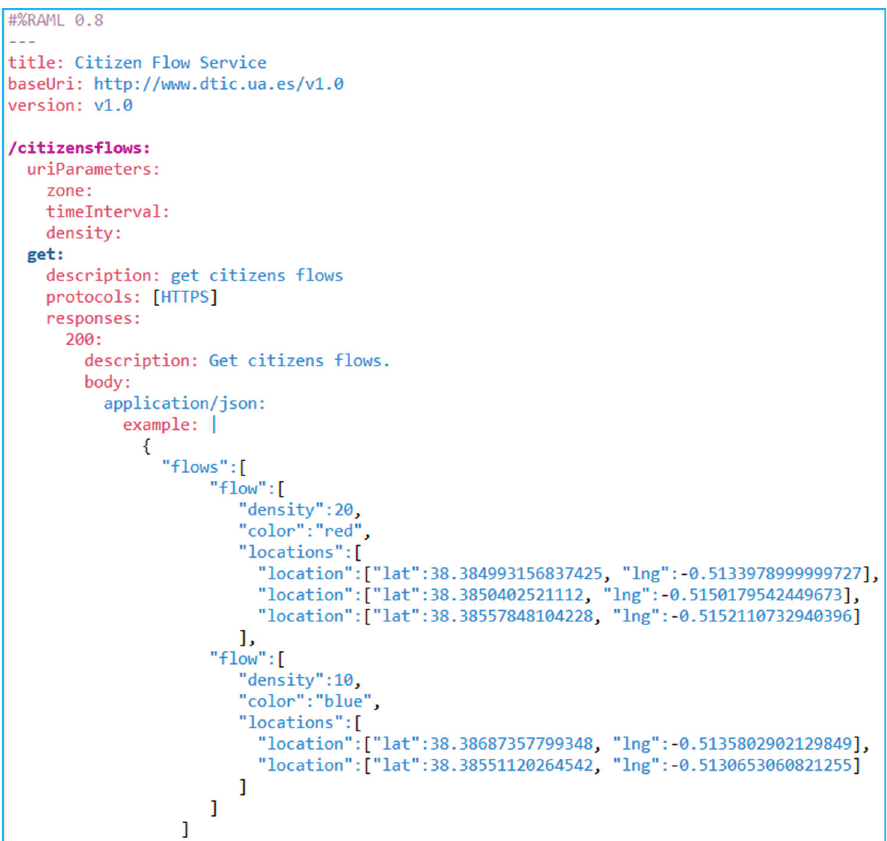
Figure 11. Citizen flow service RAML